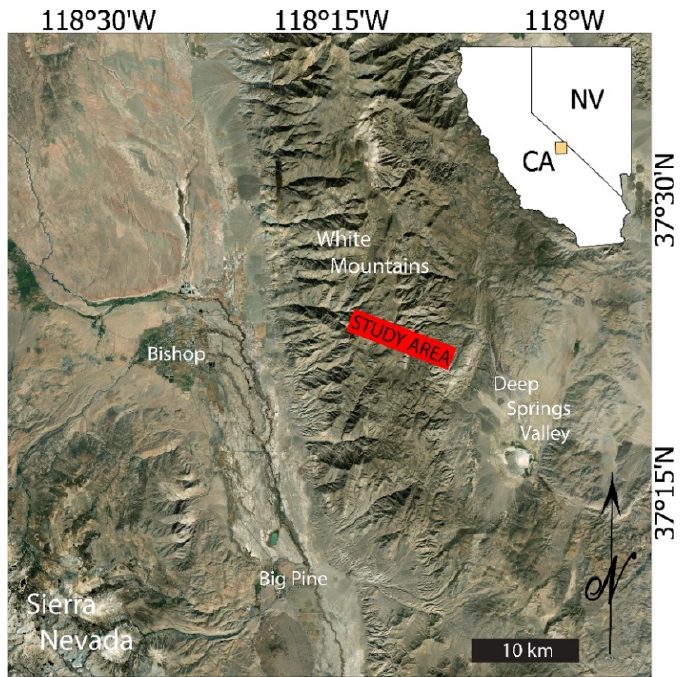
Figure 1. Overview map showing regional context of the study area in Eastern California. Extent of the main frame is shown as an orange square inset at upper right. Extent of the study area is covered by a red box. The image in the main frame is shown in true color.